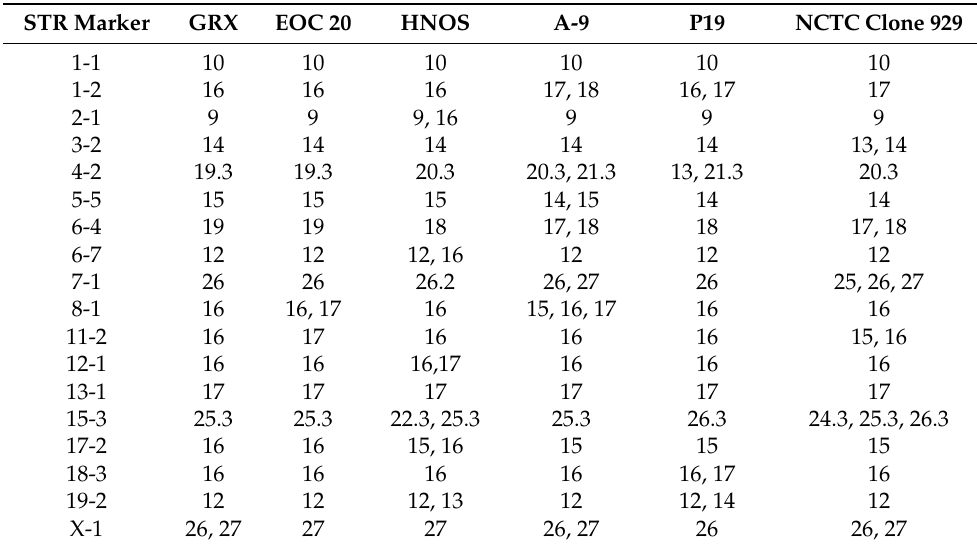
* The mouse STR markers of GRX from this second analysis were used to search the Cellosaurus database (release 38.0) by using the STR similarity search tool (CLASTR 1.4.4) at Expasy [25,47]. The STR profiles of cell lines EOC 20 (CVCL_5745), HNOS (CVCL_M838), A-9 (CVCL_3984), P19 (CVCL_2153) and NCTC clone 929 (CVCL_0462) showed the highest similarity, which were 89.47% (EOC 20), 69.77% (HNOS), 66.67% (A-9), 63.41% (P19) and 62.22% (NCTC clone 929),